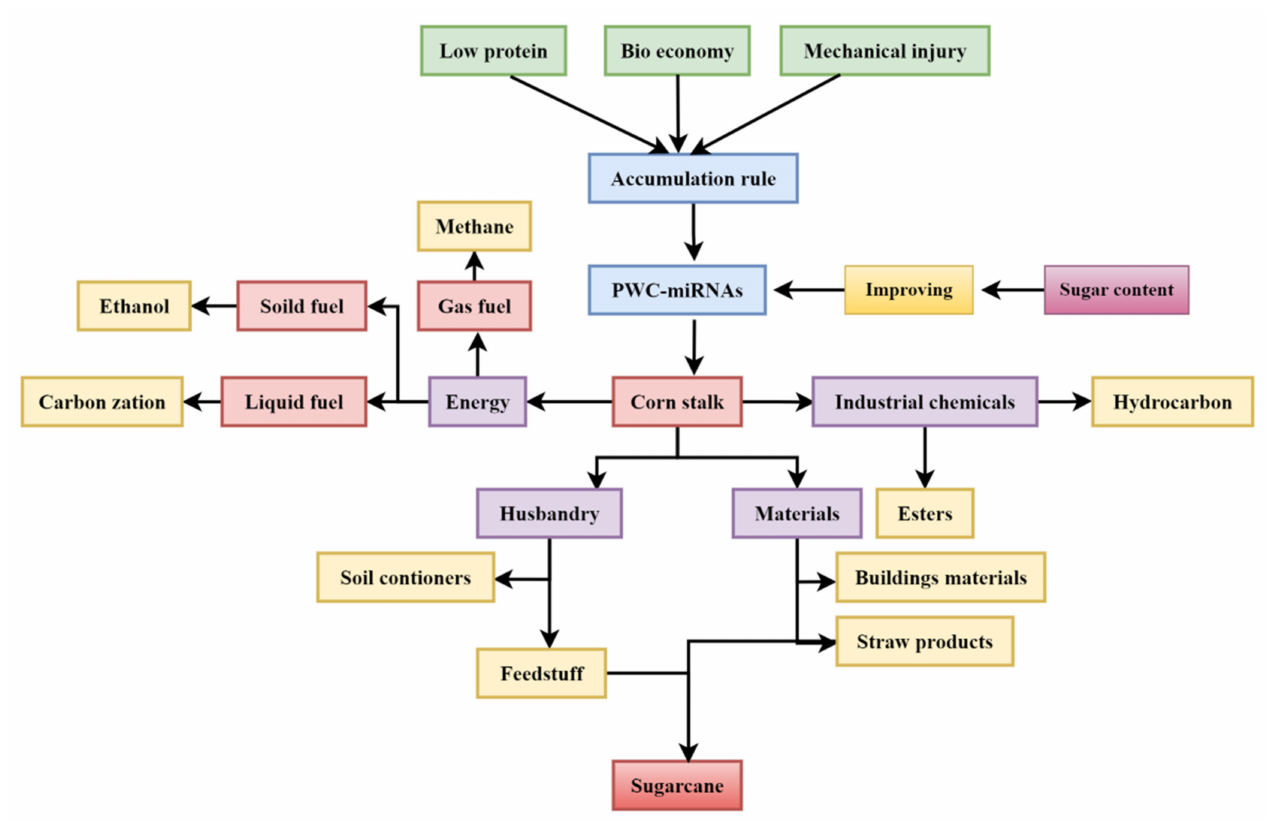
Figure 2. Conceptual framework implemented based on